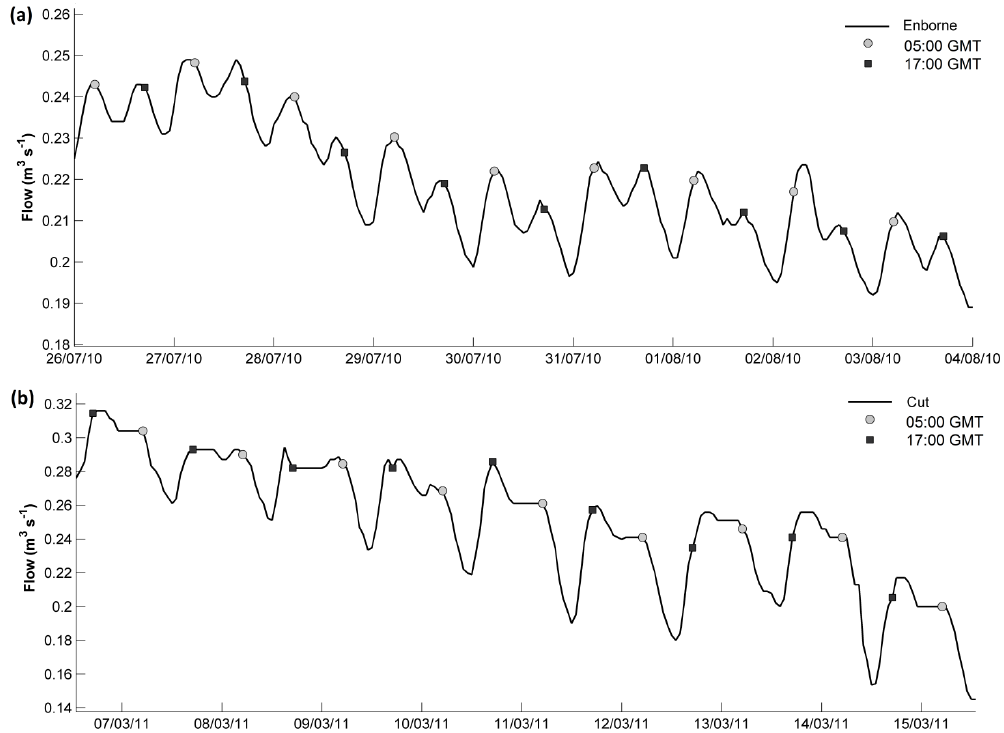
Fig. 6. Two-peak diurnal pattern within the catchment flow time series on (a) the River Enborne and (b) The Cut. For the periods shown, the two catchments are exhibiting a similar phasing in the flow diurnal cycle, with peak flows occurring at either 05:00:00 or 17:00:00GMT, followed in each case by a secondary peak 12h